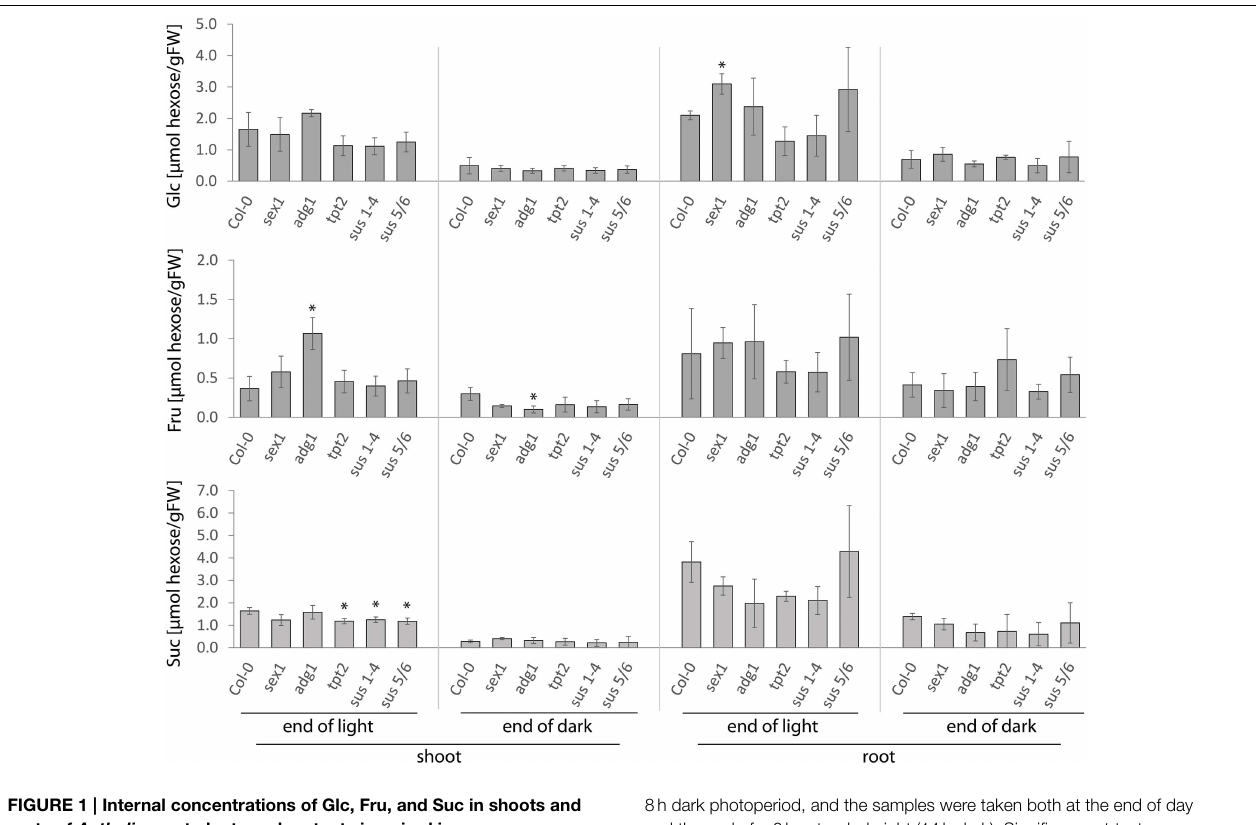
FIGURE 1 | Internal concentrations of Glc, Fru, and Suc in shoots and roots of A. thaliana wt plants and mutants impaired in CH-metabolism. Plants were grown for 13 days on agar under 16h light/